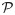
Test 1: Variability of the FOM and DL-ROM solutions over the parameter space.FOM (right) and DL-ROM (left) AP variability over P at P = (7.46, 6.51) cm. The DL-ROM sharply reconstructs the FOM variability over P.